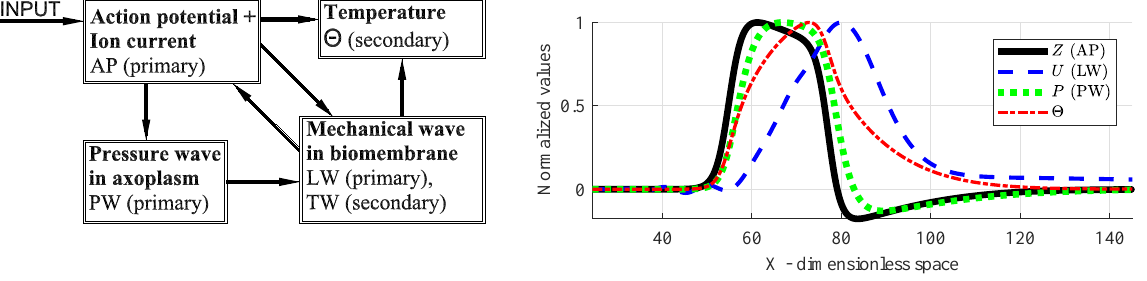
Fig. 1. Left panel – the wave ensemble block diagram. Right panel – action potential Z , pressure P , longitudinal density change U , and temperature Q left-propagating profiles: an example from [37]. Temperature profile corresponding to the case F 3 = t 3 Z T + t 4 J T